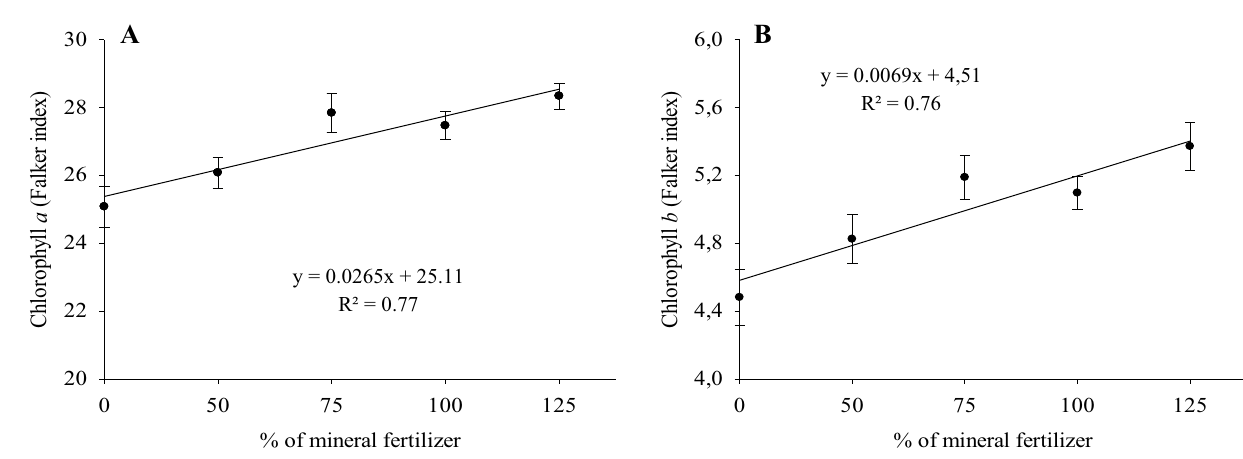
Fig. 2 Soybean leaf levels of chlorophyll a ( a ) and b ( b ) at 30 days after